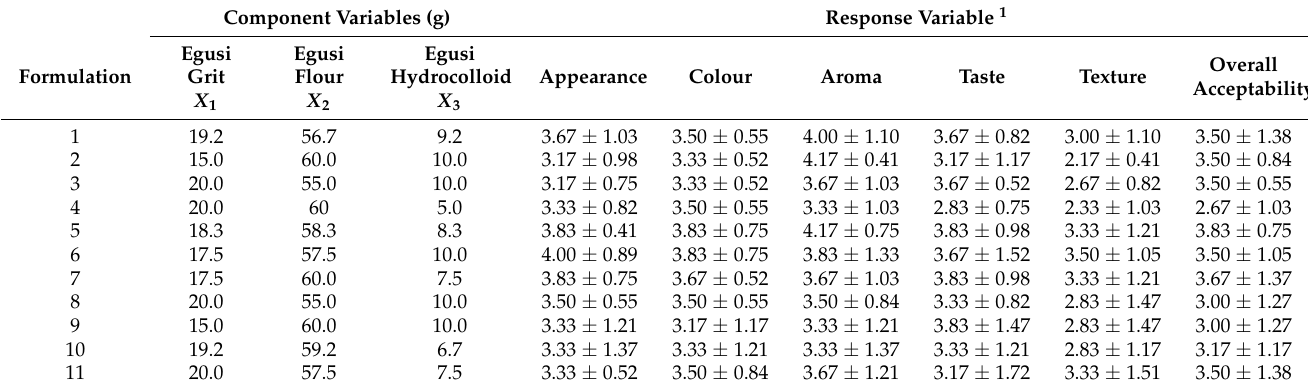
Table 2. Sensory properties of instant egusi soup mix formulation for the boiled egusi grit.